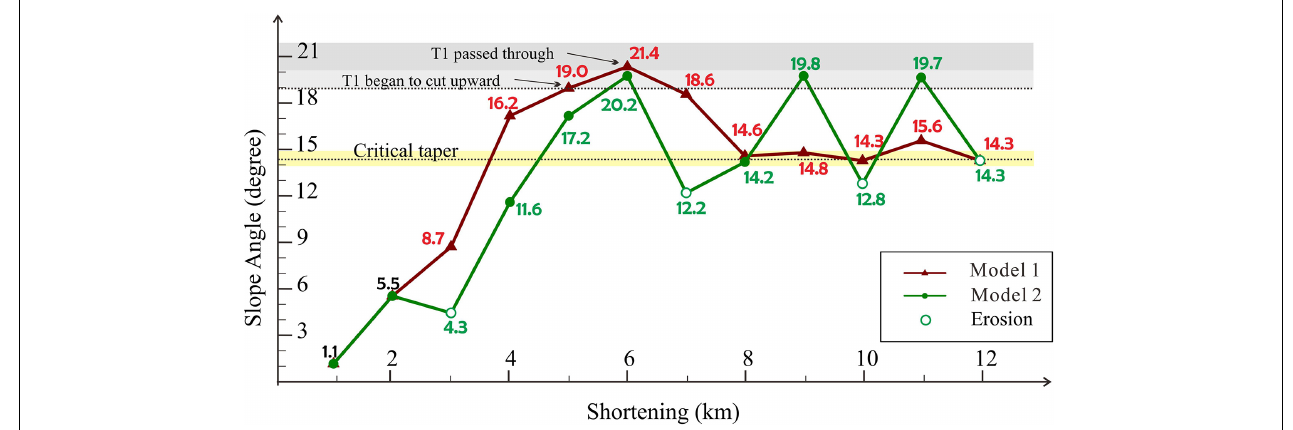
FIGURE 8 | Comparison of the slope angle versus shortening for the two